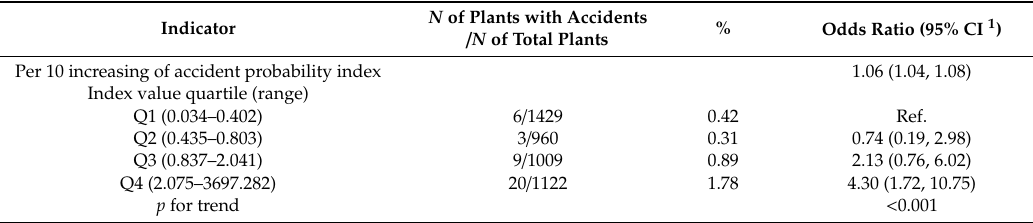
Table 5. Results of logistic regression analysis for actual occurrence of chemical accidents in 2015–2018 by the accident probability